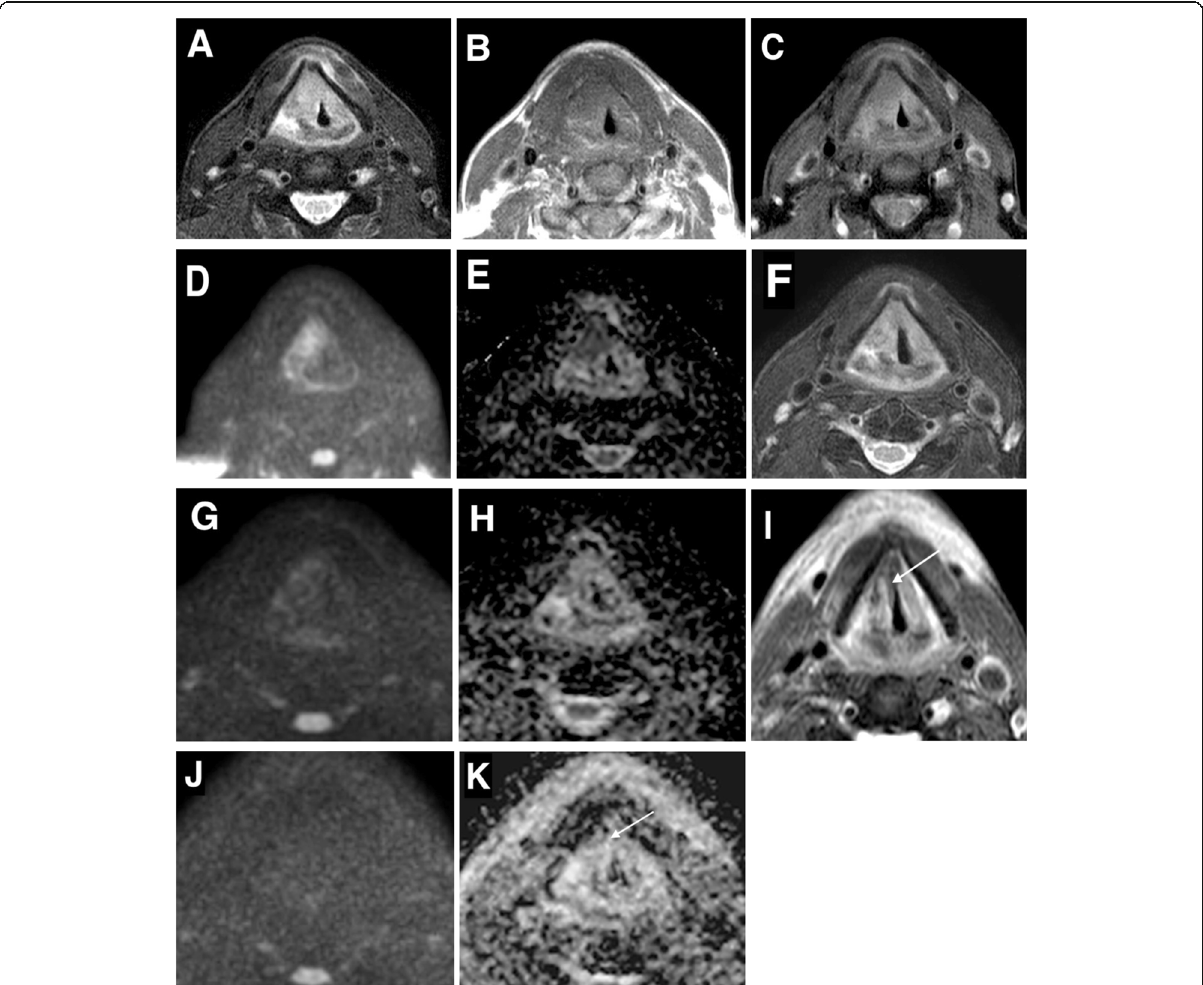
Fig. 2 A 59-year-old male patient with right sided transglottic laryngeal SCC (T4aN0M0) treated by radiotherapy. a – e Axial pretreatment MR images. a T2WI with fat suppression, b non-contrast T1WI, c post-GAD T1WI with fat suppression, d b-1000 TSE-DWI, e the corresponding ADC map, all showed moderately hyperenhancing T2 hyperintense right sided transglottic soft tissue mass with restricted diffusion (ADC = 0.82 × 10 − 3 mm 2 /s), f – h axial midtreatment MR images performed 2 weeks after start of radiotherapy. f T2WI with fat suppression. g b-1000 TSE-DWI, h the corresponding ADC map, all showed mild regression in size of the tumor with elevation of ADC value (1.26 × 10 − 3 mm 2 /s). i – k Axial MR images 6 weeks after end of radiation therapy. i T2WI, j b-1000 TSE-DWI, k the corresponding ADC map, revealed local control and complete disappearance of the tumor without diffusion restriction. Clinical/radiological follow-up for 1 year after end of treatment showed no